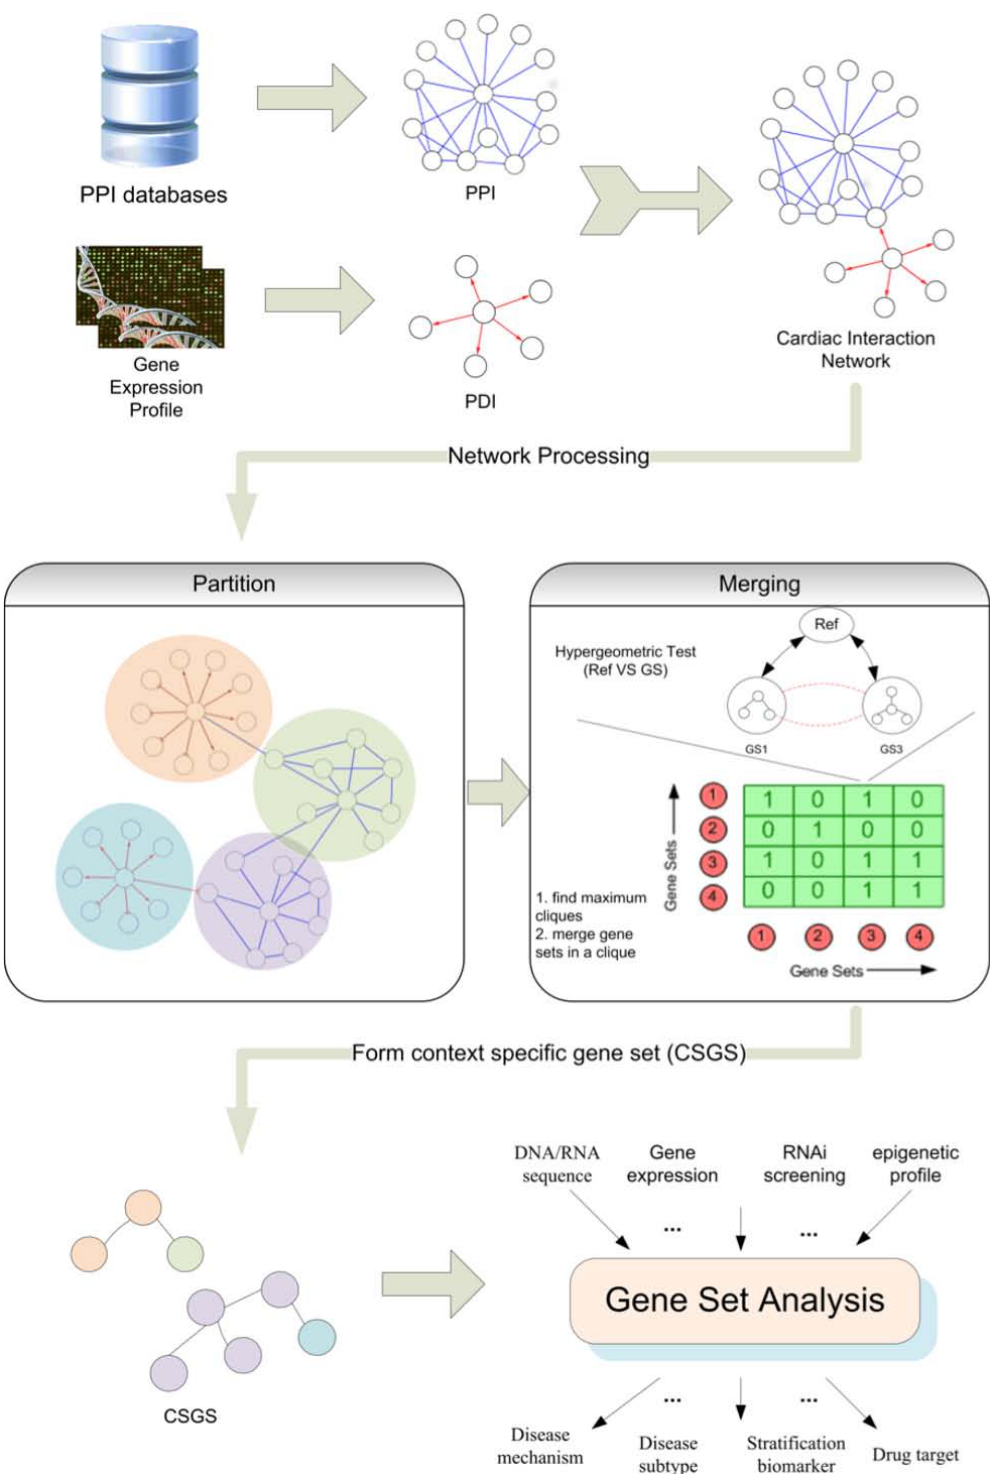
Figure 2: The flowchart of our context-specific gene set assembly pipeline. The PPI network is integrated from 4 major databases and the PDI network is reconstructed using ARACNe, an information theory-based reverse engineering algorithm. The cardiac interactome consists of both PPI and PDI networks. Network partitioning is first implemented to identify initial subnets with strong connectivity (PPI) or sharing a common regulator (PDI). Then, pathway and functional annotations are taken into consideration to merge neighboring subnets with a functional tie. The final sets of subnets will form a collection of Cell context-Specific Gene Sets (CSGS) that could facilitate GSA in various applications, ranging from understanding disease pathogenesis to the discovery of patient stratification